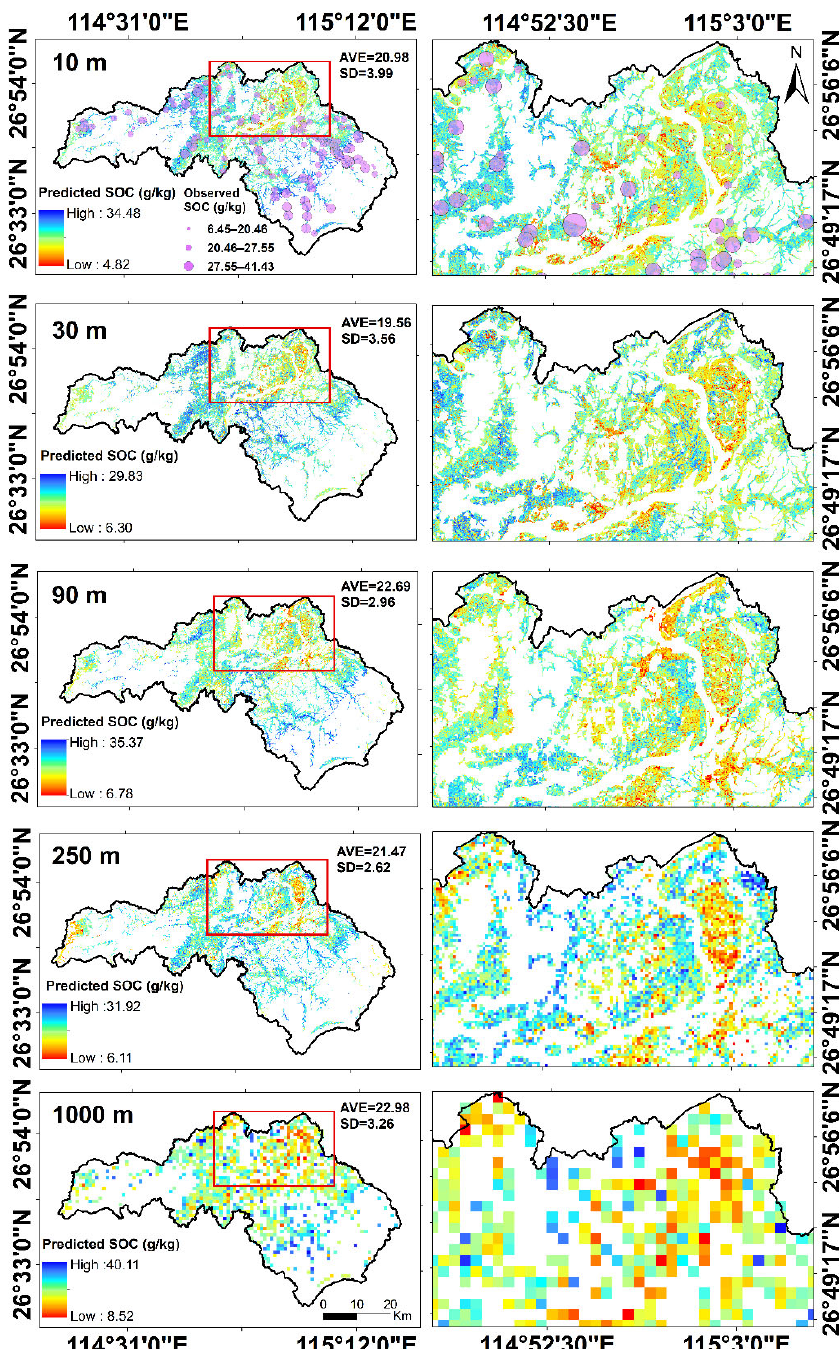
Figure 7. The distribution maps of cropland SOC contents predicted by the XGBoost technique at 10 m, 30 m, 90 m, 250 m and 1000 m resolution, respectively. The maps were masked by GlobeLand30 2020 land cover dataset to derive SOC contents of croplands in the study area. AVE and SD correspond to the average values and standard deviation values of predicted SOC, respec ‐ tively.